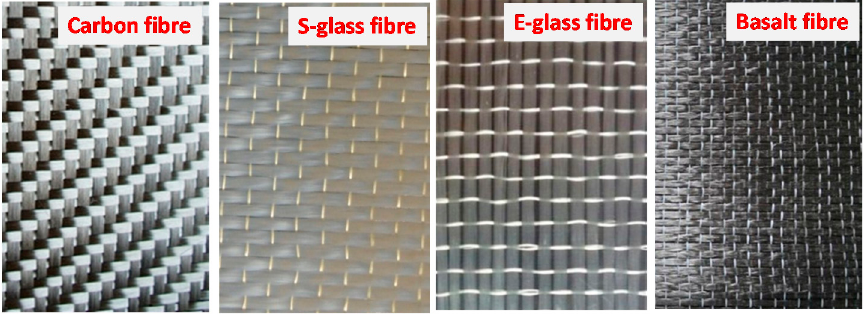
Figure 2. FRP sheet materials used in the study.